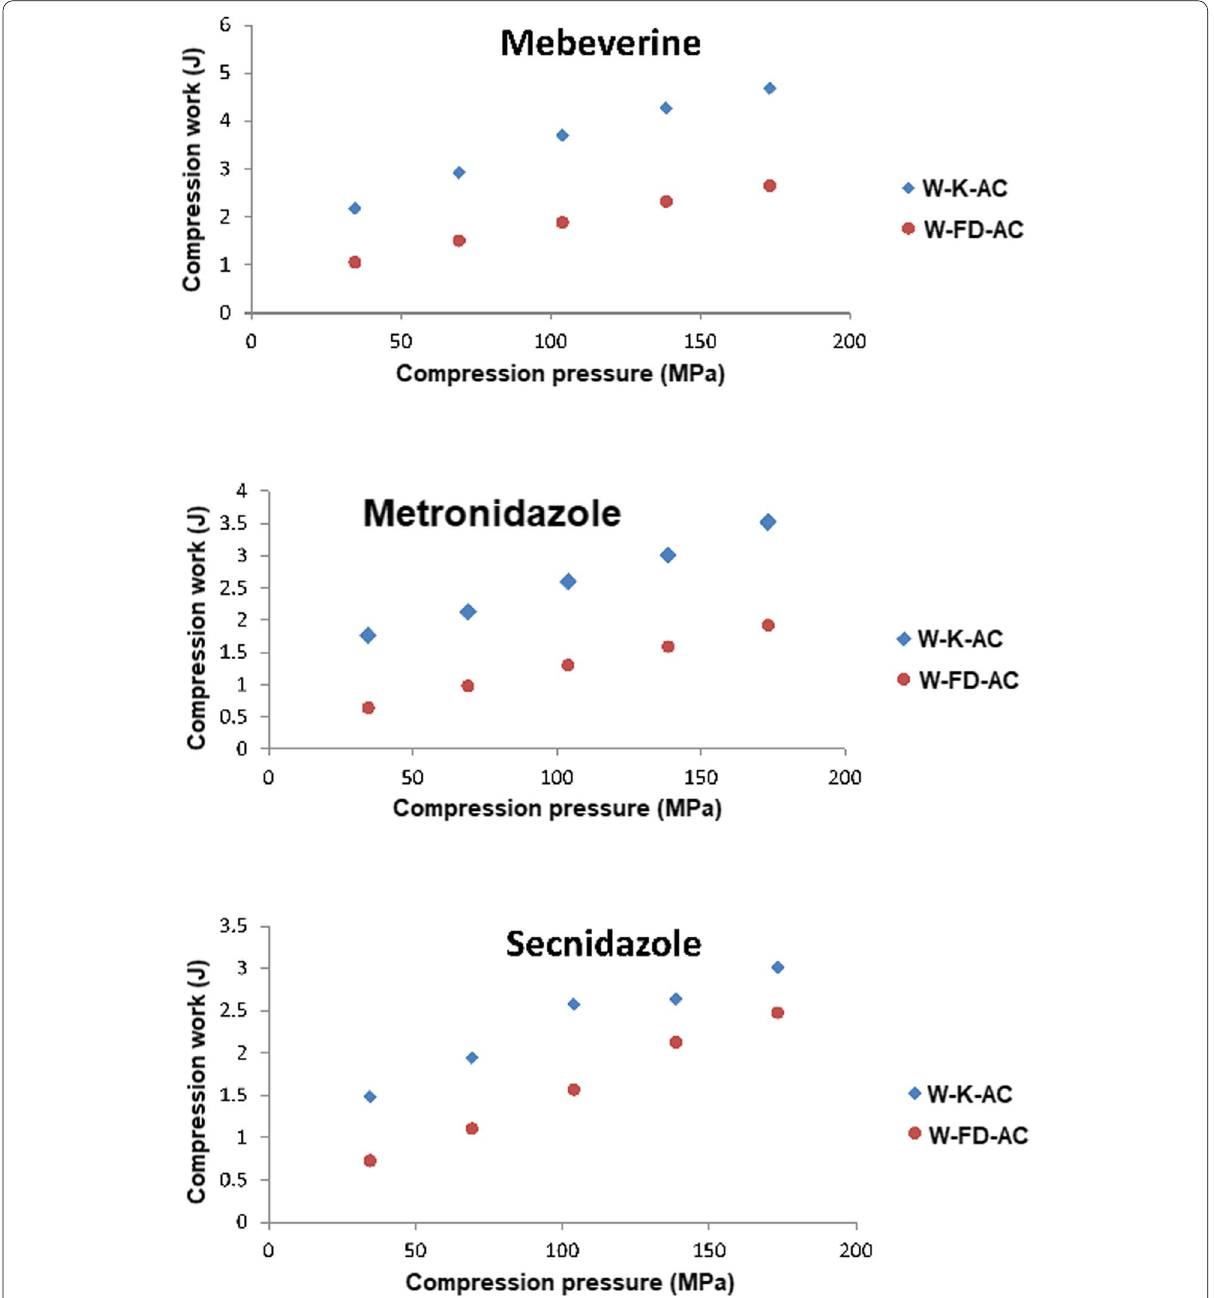
Fig. 8 Work of compression calculated using the integrated form of Kawakita equation (Eq. 4) and the F-D curve for the drugs comprising compacted mebeverine, metronidazole, and secnidazole all compressed at compression pressures 34–173